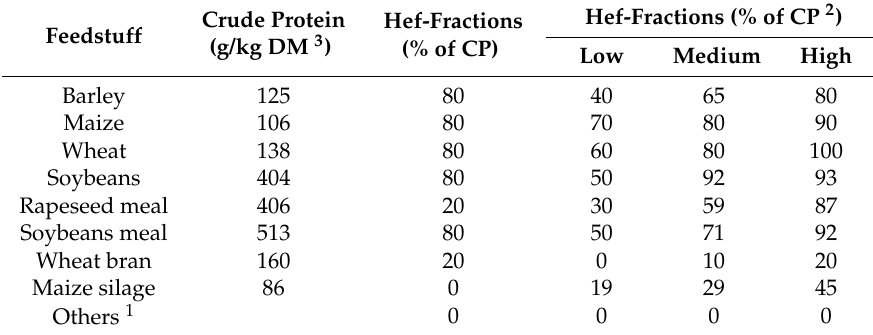
Table 2. Crude protein content of some feeds [60] and their human-edible fraction (hef; in %) (taken from Wilkinson [57]) and for three different estimation scenarios from Ert et al. [58]. Crude